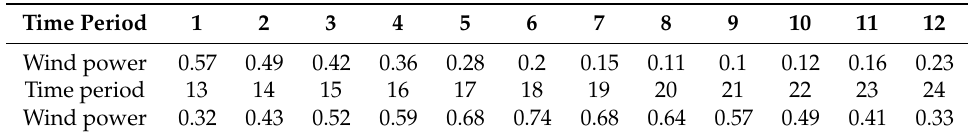
Table A1. The day-ahead predicted wind power data (p.u.).